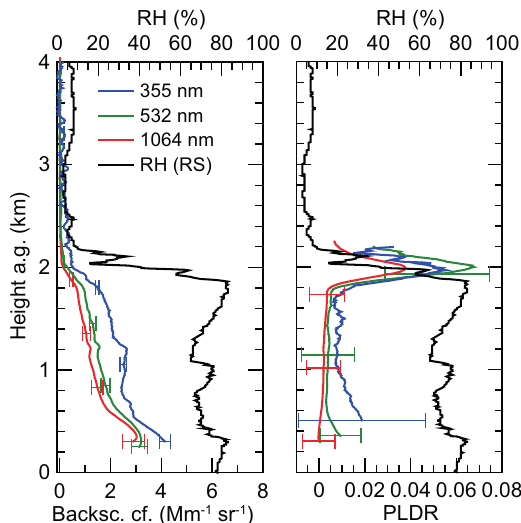
Figure 3: Vertical profiles of particle optical properties observed on 24 February 2014, 22:12 - 24:00 UTC. Shown are the particle backscatter coefficient (left) and the PLDR (right) at 355 nm (blue), 532 nm (green) and 1064 nm (red). The profile of RH measured by the radiosonde is shown in both plots. Note that the drastic change in RH from 80% to less than 10% occurs within 200